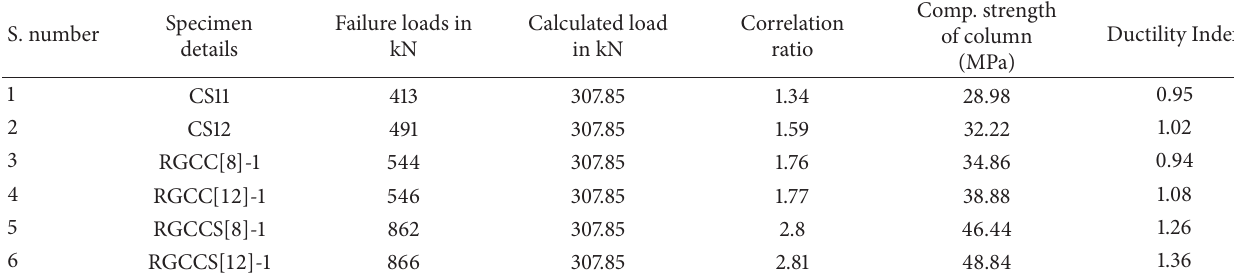
Table 4: Details of columns and their